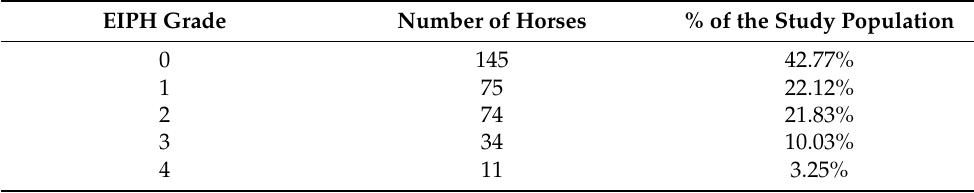
Table 4. Frequency and grade distribution of exercise-induced pulmonary hemorrhage (EIPH) among the study